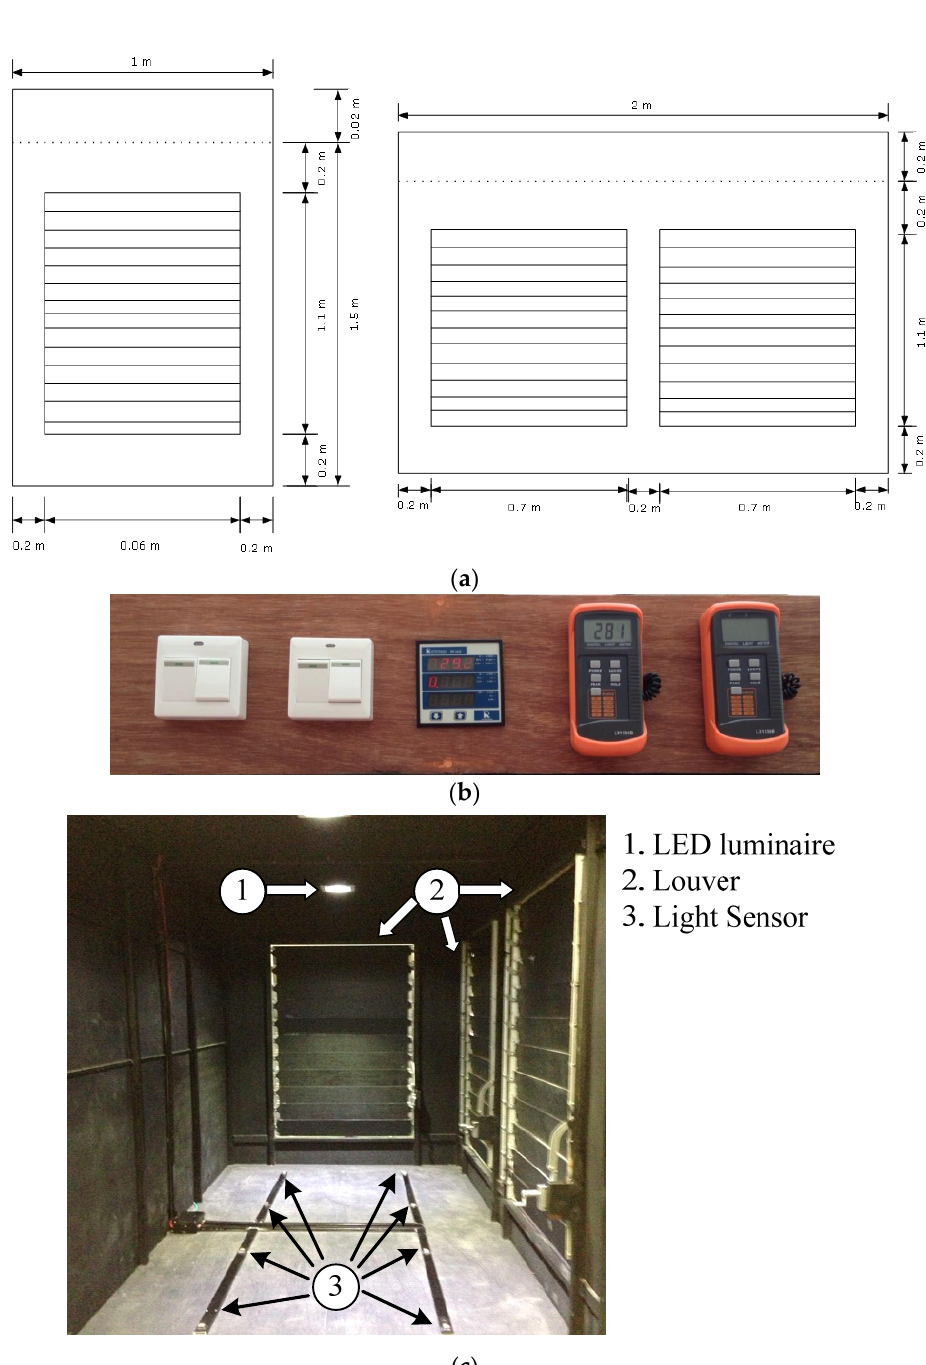
Figure 4. The field test experimental unit: ( a ) layout of exterior; ( b ) Front panel; ( c ) Interior.